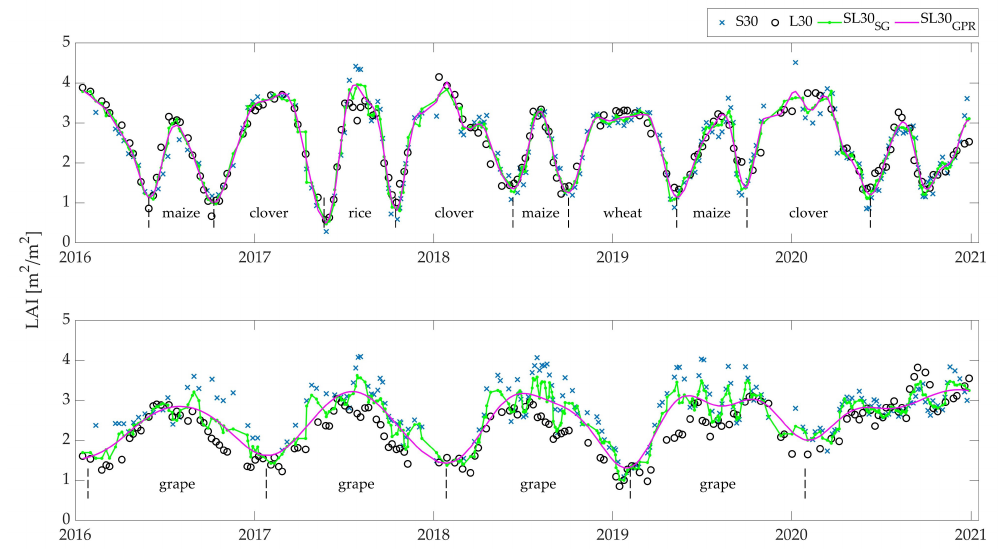
Figure 3. Comparison of S30 and L30 green LAI time series, respectively, derived from S2 and L8 HLS acquisitions and the reconstructed combined LAI time series (SL30 SG and SL30 GPR ) over a multiple ( top ) and single ( bottom ) cropping